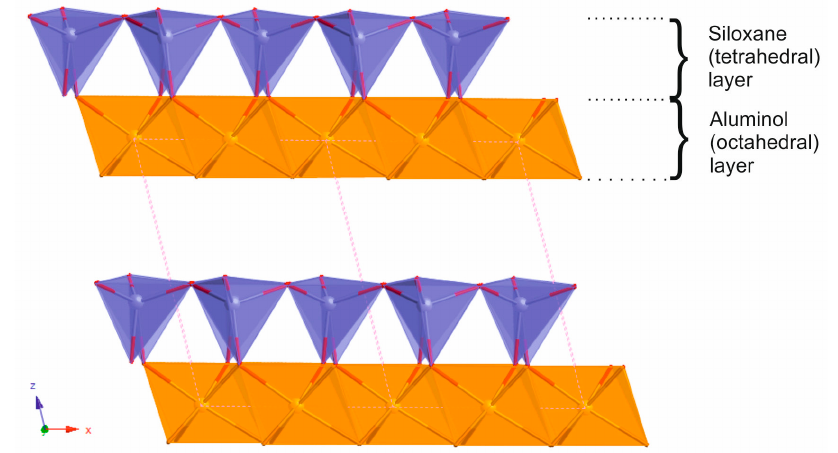
Figure 1. Detail of the kaolinite crystal structure perpendicular to the <010> direction. Two 1:1 layers are shown in the drawing, with siloxane and aluminol layer highlighted in the upper one. Clearly visible are the distinct nature of both upper and lower crystal termination.